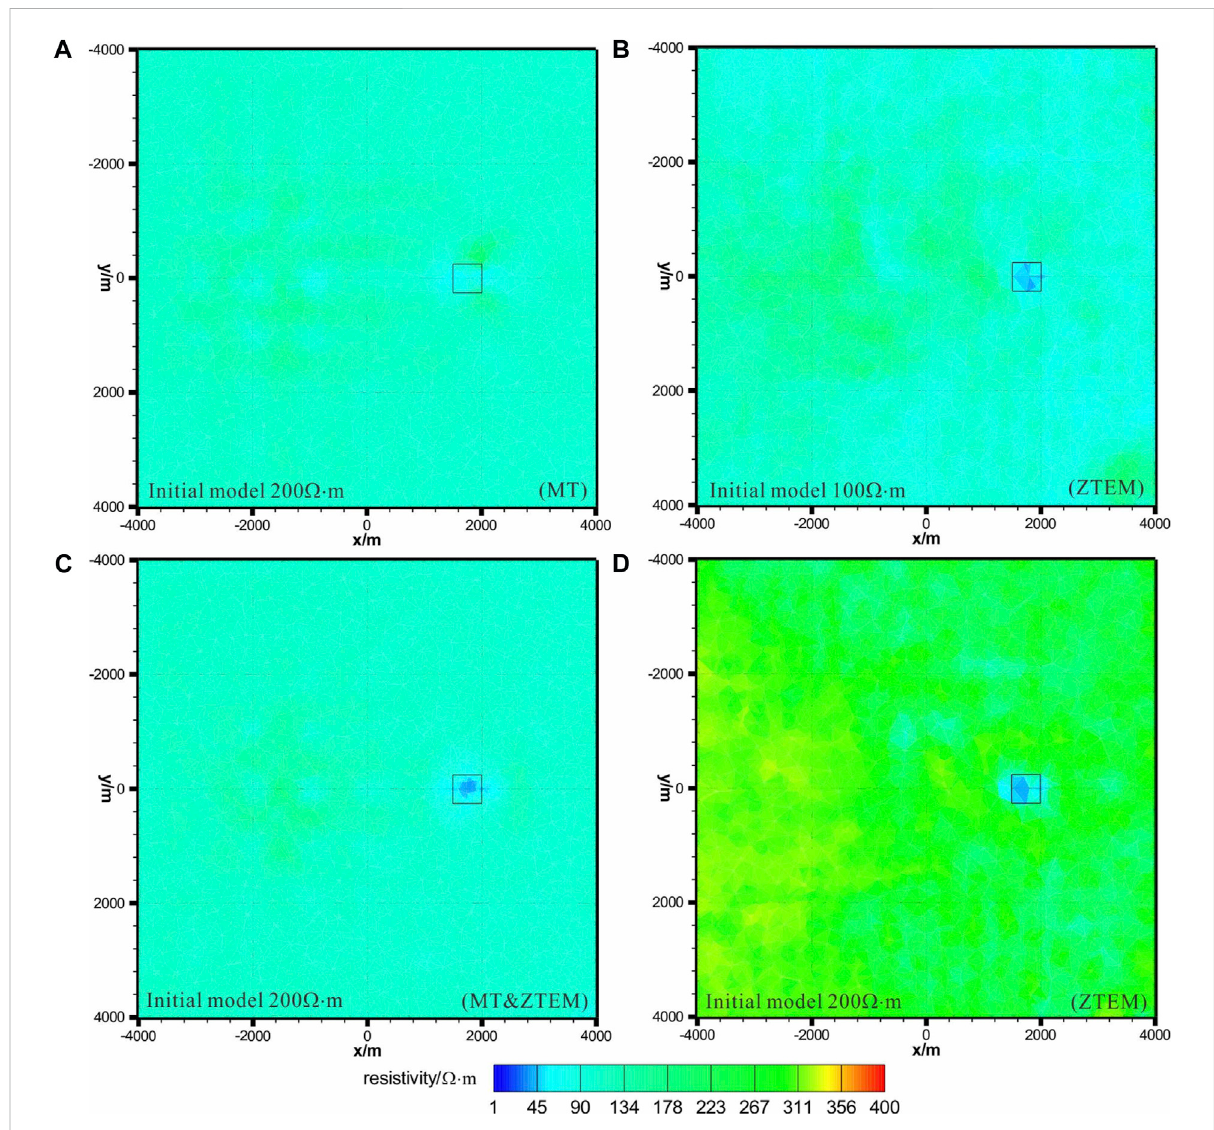
FIGURE 6 Inversion results for the synthetic model with topography at xy section for z= − 450 m. (A,D) and (C) are the MT inversion, ZTEM inversion, and joint MT and ZTEM inversion with initial model and a 200 Ω · m half-space, respectively. (B) is the ZTEM inversion with a 100 Ω · m